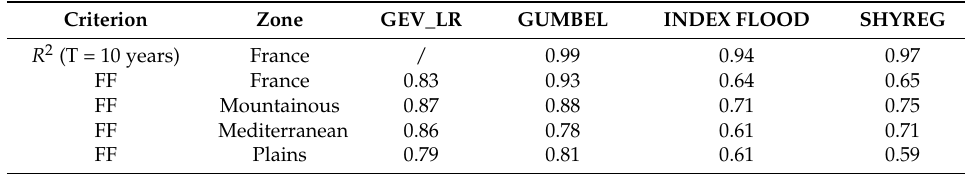
Table 3. Criterion values for at-site implementations of the different FFA